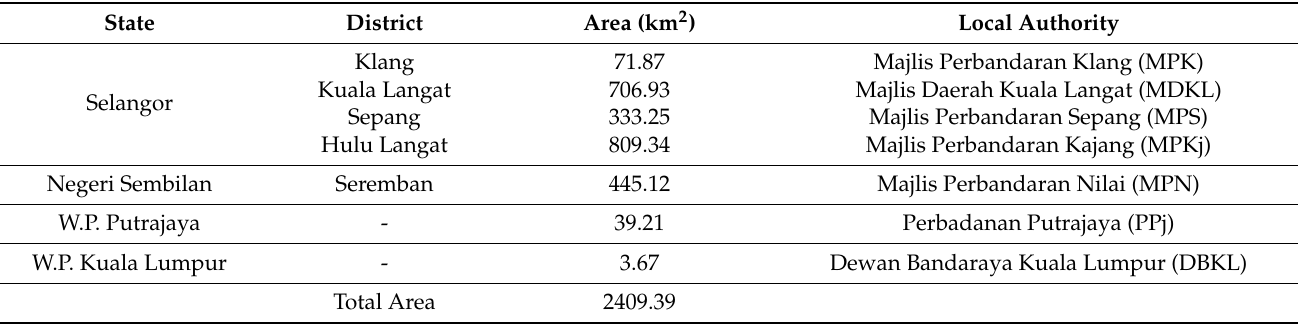
Table 1. Administrative areas of Langat River Basin,